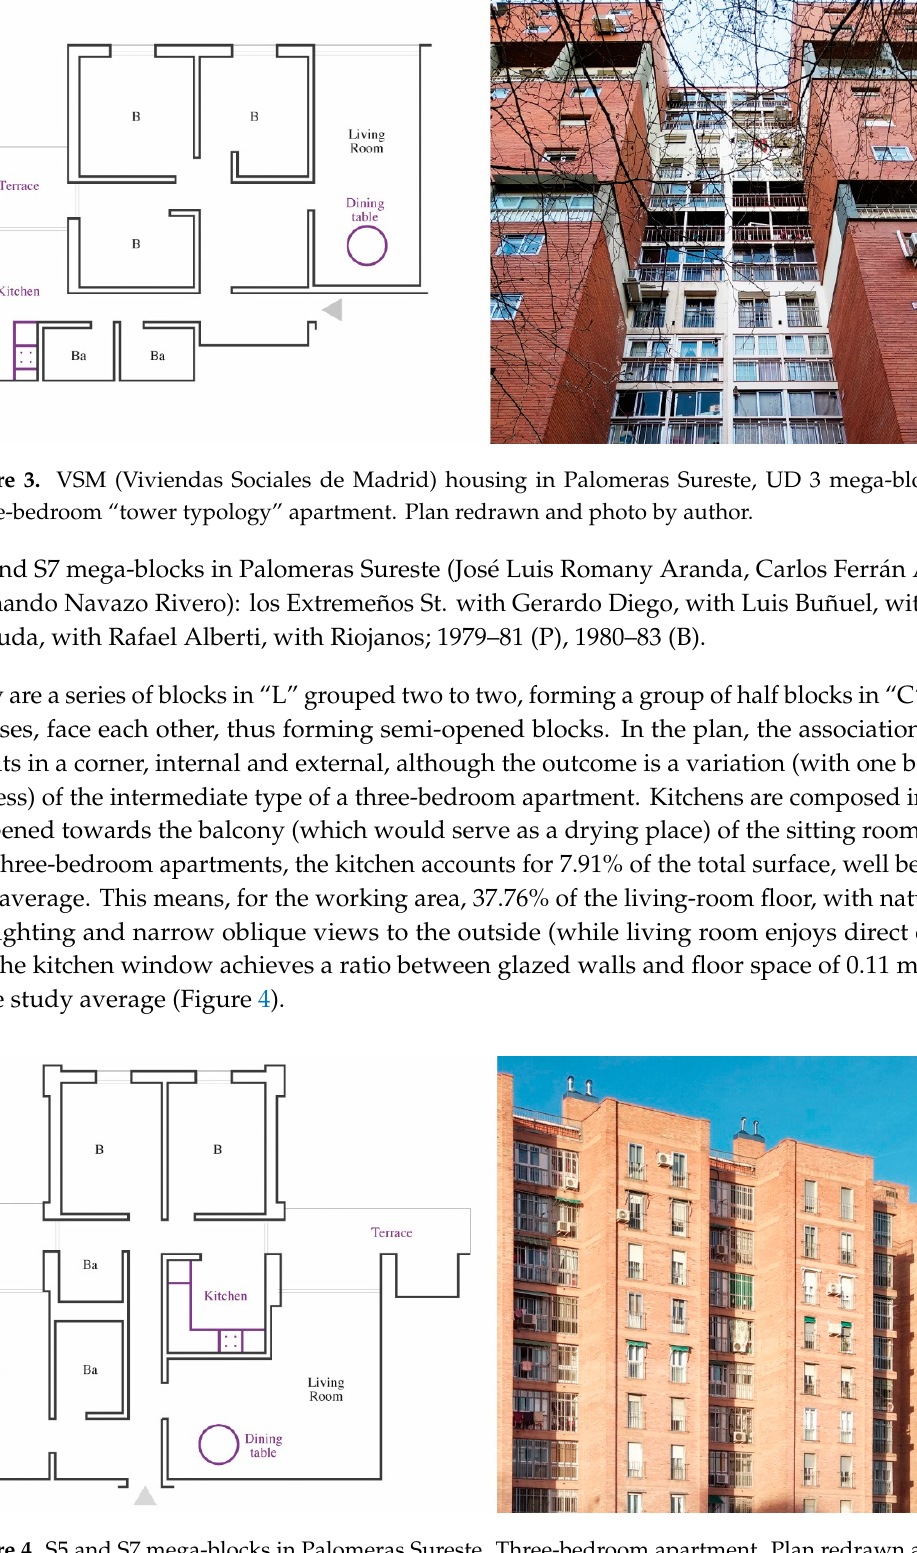
Figure 4. S5 and S7 mega-blocks in Palomeras Sureste. Three-bedroom apartment. Plan redrawn and photo by author.